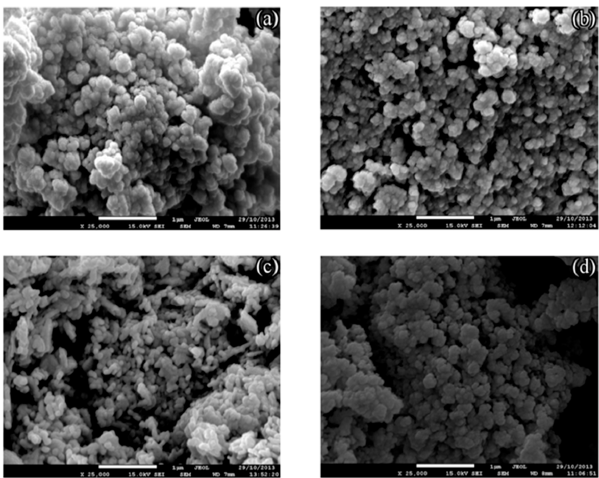
Figure 2. FESEM images of some commonly used NPs: ( a ) TiO 2 ; ( b ) Al 2 O 3 ; ( c ) NiO; ( d ) SiO 2 [16].